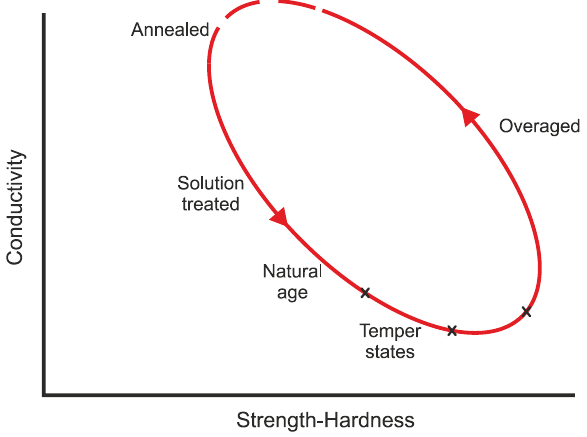
Figure 8. Variation of aluminum conductivity with heat treatment (adapted from [23]).